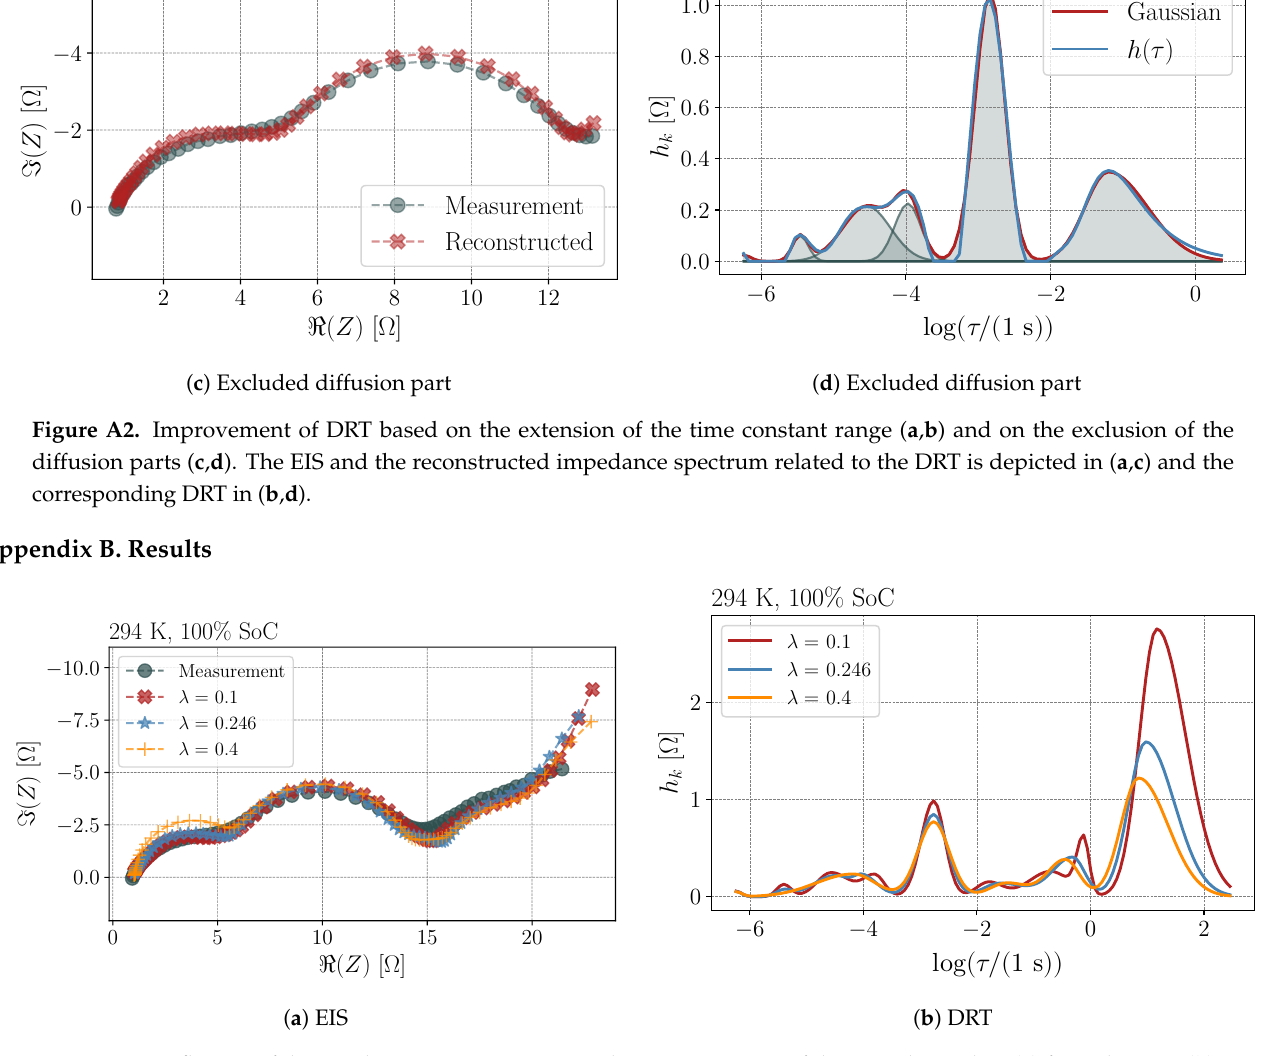
Figure A3. Influence of the regularization parameter on the reconstruction of the impedance data ( a ) from the DRT ( b